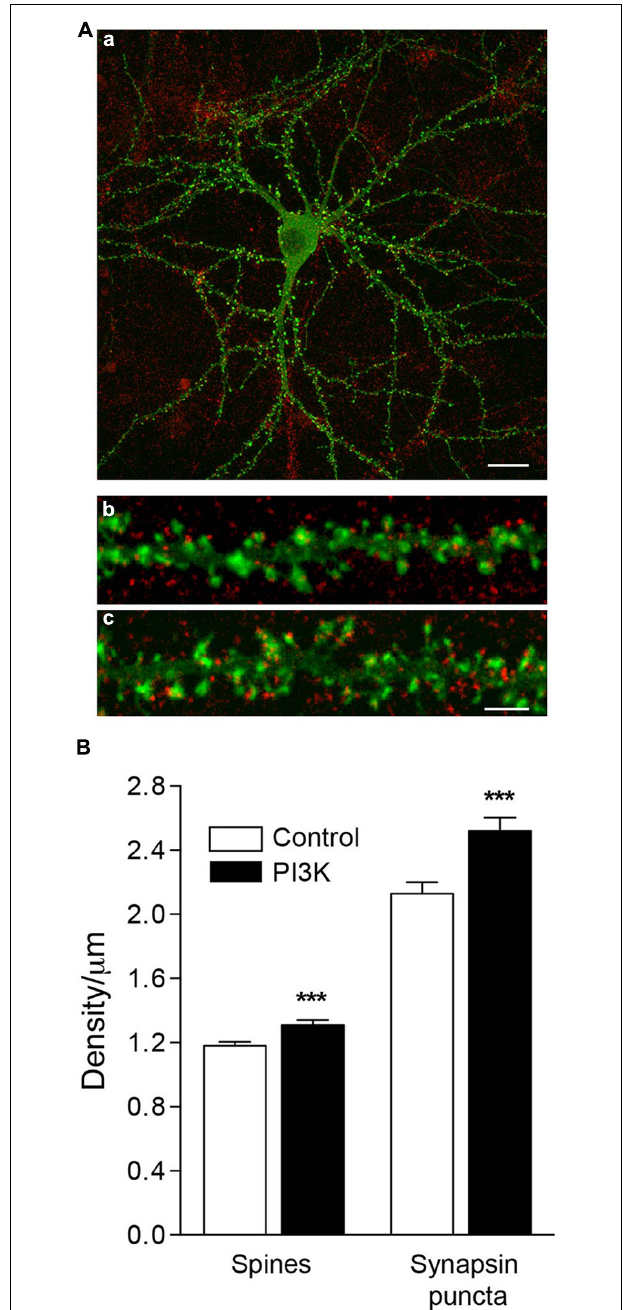
FIGURE 6 | PI3K activation induces the formation of functional spines in culture. (A) An example of an actin-GFP (green) transfected neuron at 21DIV (a), fixed and immunostained for synapsin (red). Magnified images show a detailed section of dendritic spines under control conditions (b) and after 48 h of PTD4-PI3KAc addition (c). Synapsin puncta were clearly visible, associated with the spines. Scale bar = 20/2.5 μ m. (B) Left bars: quantification of spine density after 48 h of PTD4-PI3KAc treatment. Control: 1.18 ± 0.02 and PTD4-PI3KAc: 1.31 ± 0.03 spines/ μ m. Right bars: quantification of synaptic puncta after 48 h of PTD4-PI3KAc treatment. Control: 2.13 ± 0.07 and PTD4-PI3KAc: 2.52 ± 0.08 synapse/ μ m. A total number of six individual cultures, 121 control and 118 dendrites from PTD4-PI3KAc neurons were used (Student’s t